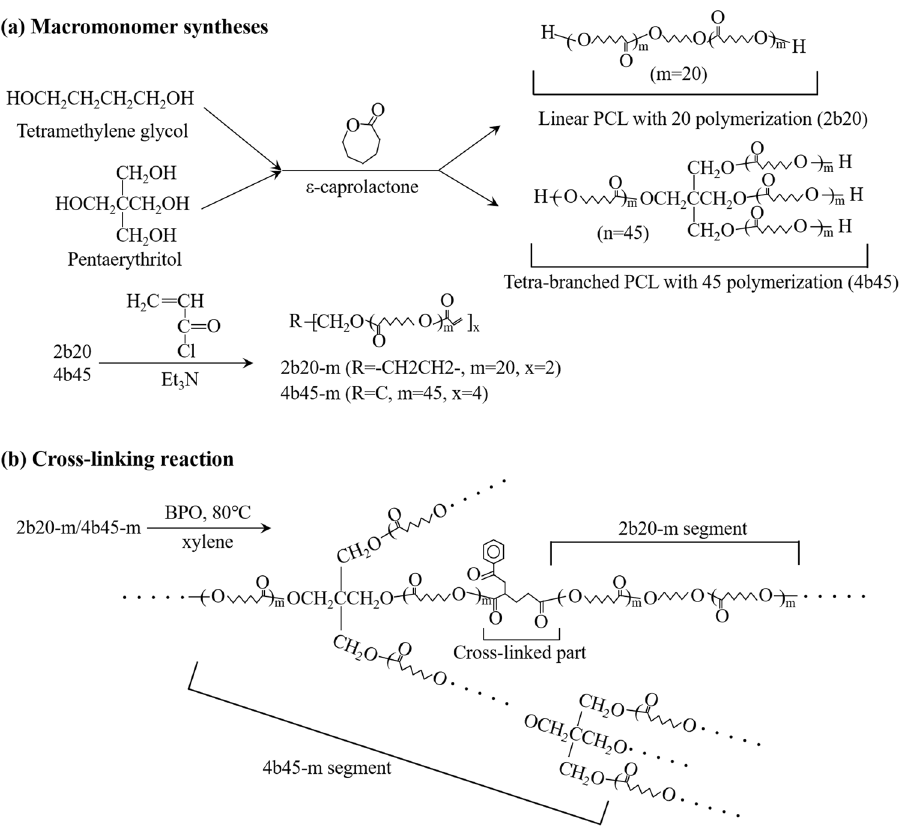
Figure 2. Schematic illustrations of (a) macromonomer synthesis and (b) cross-linking